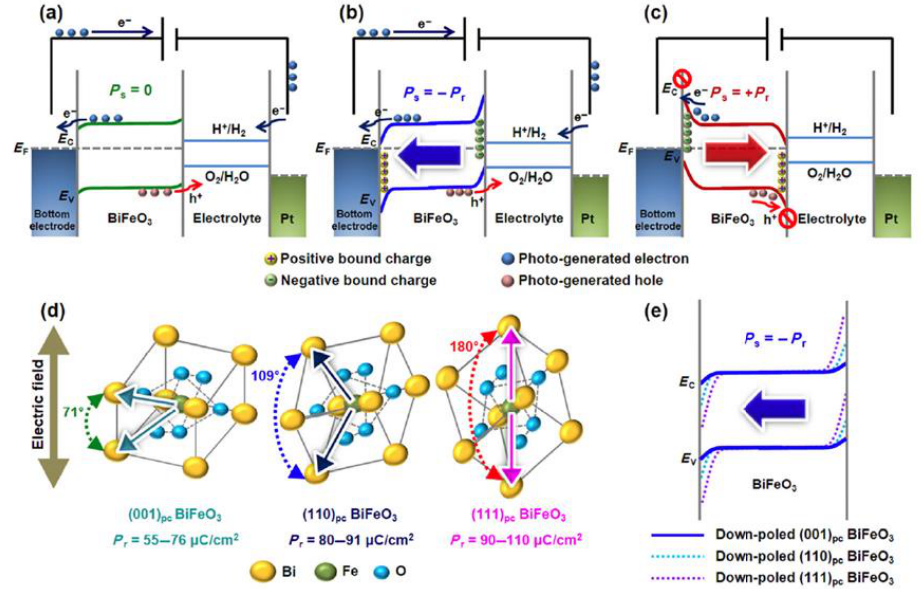
Figure 7. Schematic representations of the built-in polarization field in ( a ) no polarization state, ( b ) downward polarization state, and ( c ) upward polarization state of ferroelectric BiFeO 3 thin films. ( d ) Different polarization values of BiFeO 3 with different crystallographic orientations. ( e ) Polarization direction of the BiFeO 3 in different crystallographic orientations. Reprinted with permission from [35]. Copyright 2018, Tsinghua University Press and Springer-Verlag GmbH Germany.